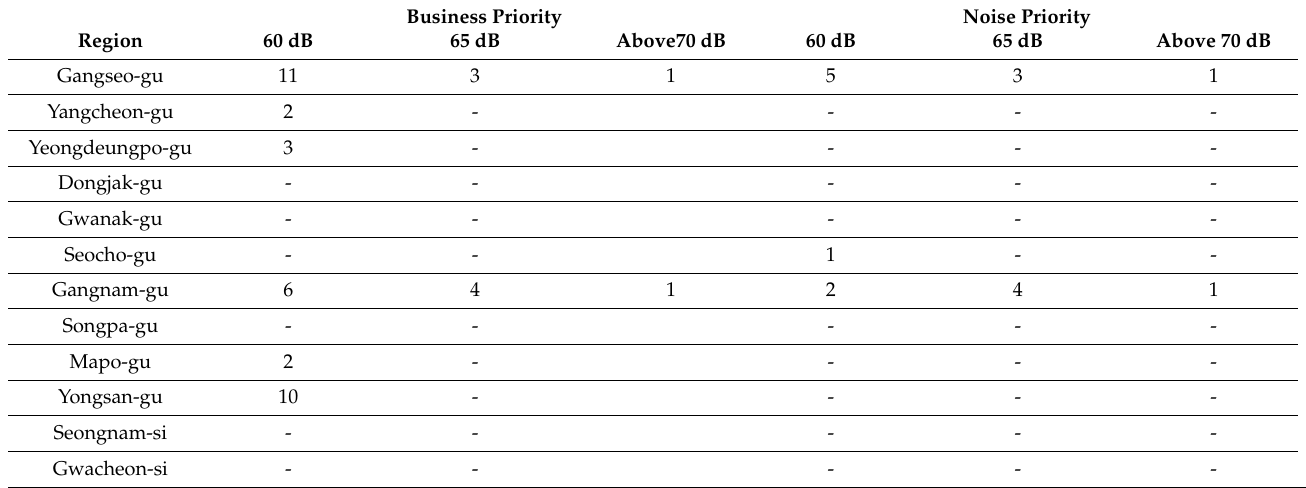
Figure 15. Noise analysis results for two different scenarios in the modeled area. Table 10. The number of hexagons per administrative district passing the noise area for two scenarios. Business Priority